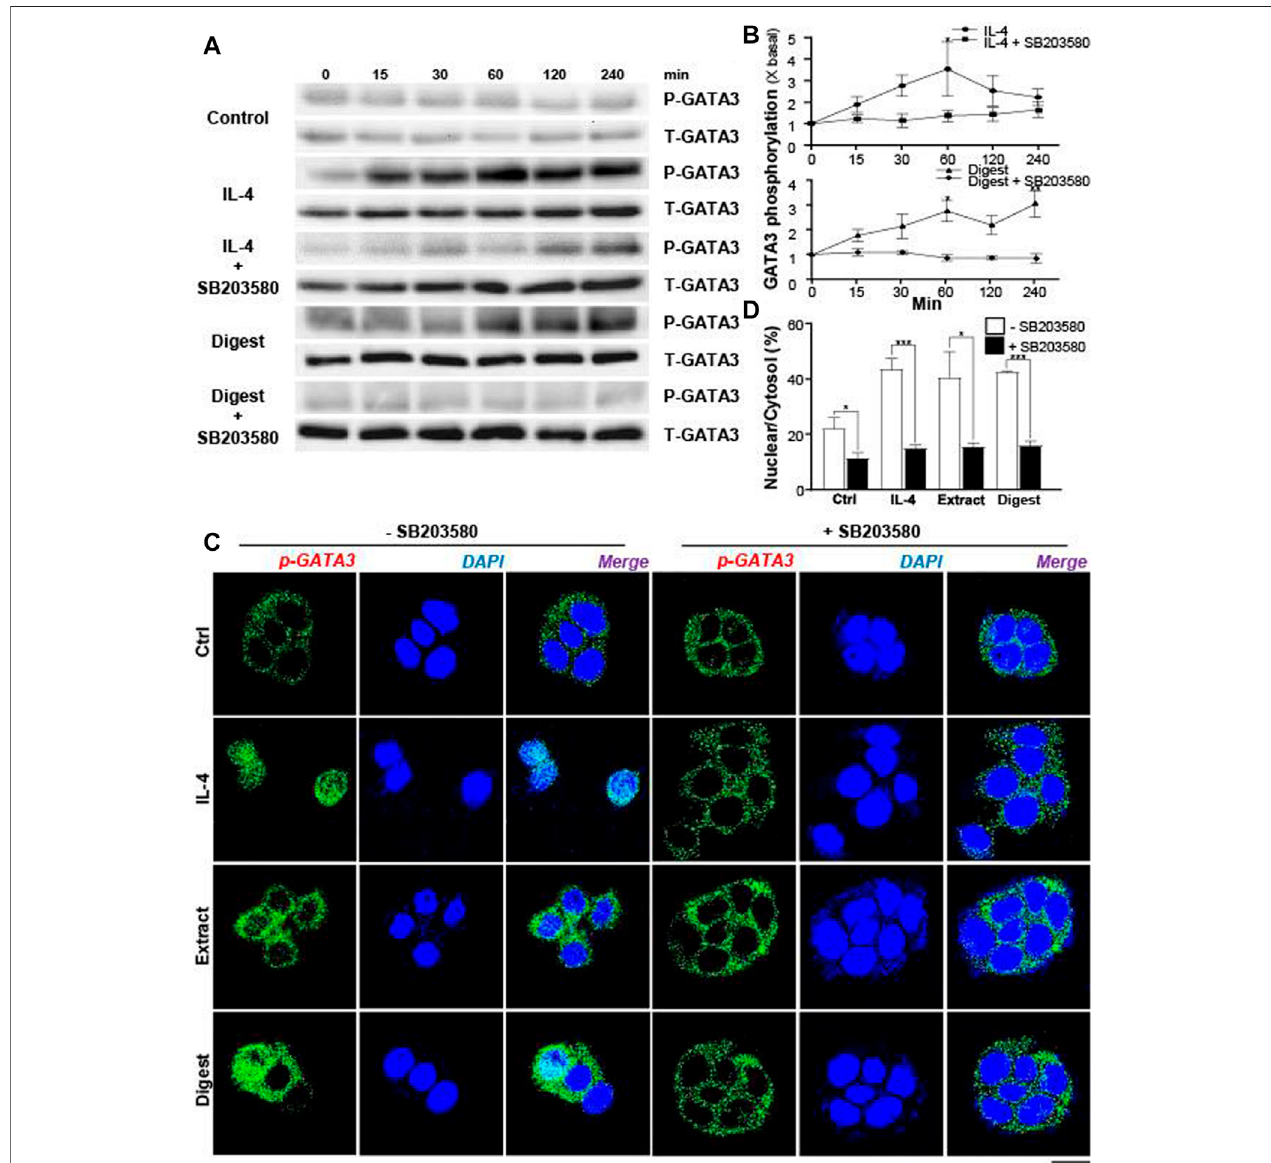
FIGURE 8 | EBN induces phosphorylation of GATA3 and its nuclear translocation. (A) After 16-h serum starvation, cultured differentiated keratinocytes were pre- incubated with or without SB203580 (10 μ M) for 2 h, followed by different time of applied IL-4 (a positive control, 100 ng/mL) or EBN digest (100 μ g/mL). Total GATA3 (T-GATA3) and phosphorylated GATA3 (P-GATA3) (both at ∼ 48 kDa) were evaluated by western blot assays. (B) The quanti fi cation of the increased fold of P-GATA3/ T-GATA3expression levels from (A) afterdifferenttimeofapplied IL-4andEBN digest,withorwithoutSB203580pre-treatment, areshown.Values areexpressed inmean ± SEM, n (cid:2) 3.Statisticallysigni fi cantresultsaremarkedwith* p < 0.05,** p < 0.01,and*** p < 0.001againstthecontrol. (C) After16-hserumstarvation,cultured differentiated keratinocytes were pre-incubated with or without SB203580 (10 μ M) for 2 h, followed by 240-min treatment of IL-4 (100 ng/mL, a positive control), EBNextract(100 μ g/mL)andEBNdigest(100 μ g/mL).PhosphorylatedGATA3proteinlocalizationinkeratinocyteswasdeterminedbyimmuno fl uorescenceassays. n (cid:2) 3. Bar (cid:2) 20 μ m. (D) The quanti fi cation of the percentage of nuclear to cytosol level of P-GATA3 intensities under different treatments from (C) are shown. Values are expressed in mean ± SEM, n (cid:2) 3. Statistically signi fi cant results are marked with * p < 0.05, ** p < 0.01, and *** p < 0.001 against the control or as